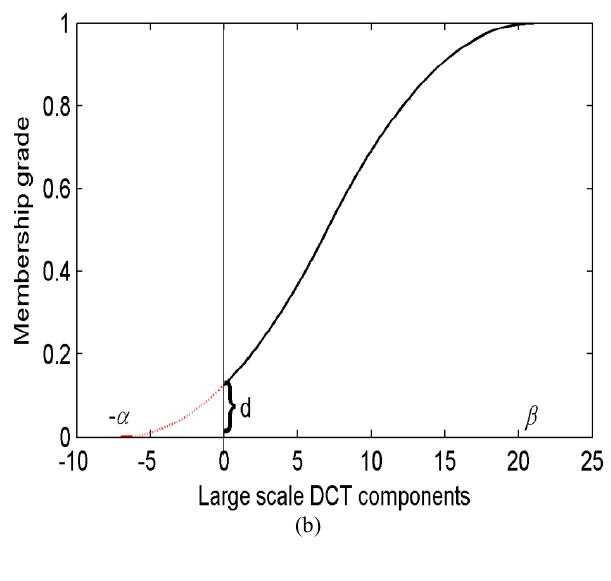
Figure 4. S membership functions (a) simple (b)